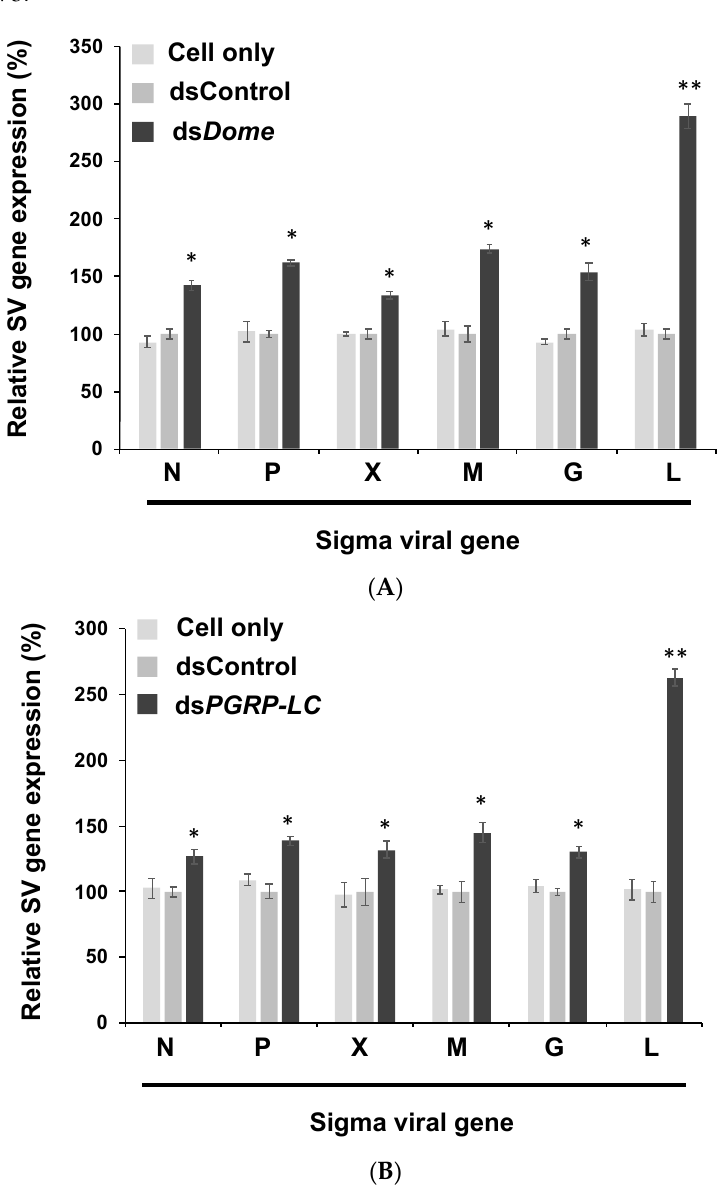
Figure 3. Blocking immune pathways resulted in a high level of viral gene expression. ( A ) The gene expression of the sigma virus in JAK-STAT pathway knockdown in S2 cells. The expression of all genes increased, and that of the L gene showed the highest increase (i.e., 4-fold). ( B ) Gene expression of sigma virus in the IMD pathway-knockdown cells. The mean and SD are shown. ** p < 0.005; * p < 0.05 one-sample t -test. All experiments were performed with three biological